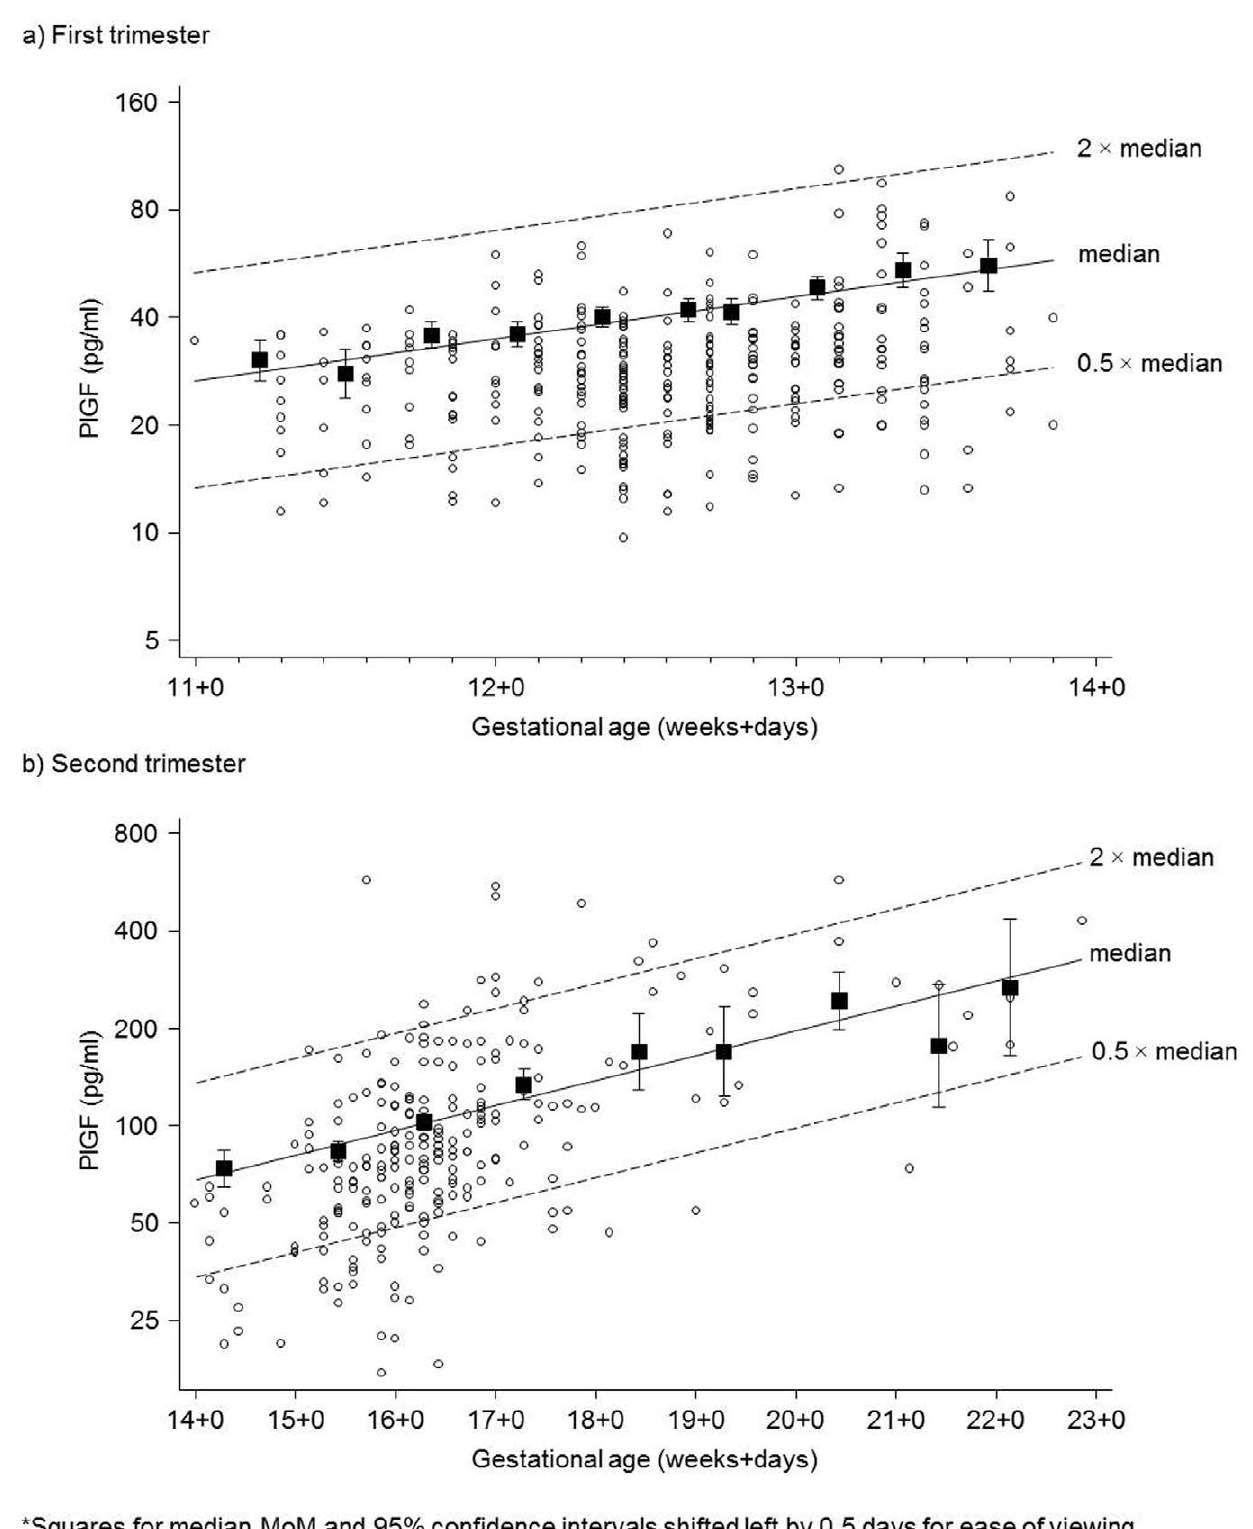
Figure 1. First trimester (a) and second trimester (b) placental growth factor (PlGF) according to gestational age in Down syndrome pregnancies (circles) and medians in 2-day intervals* (a) and weekly intervals (b) in unaffected pregnancies (squares, with 95% confidence intervals) together with expected (regressed) median in unaffected pregnancies.